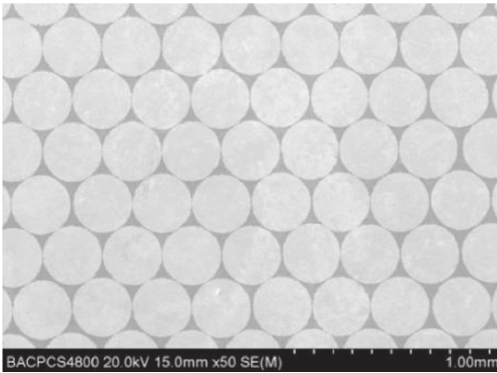
Figure 1: SEM morphology of high-density WF/Zr-MG